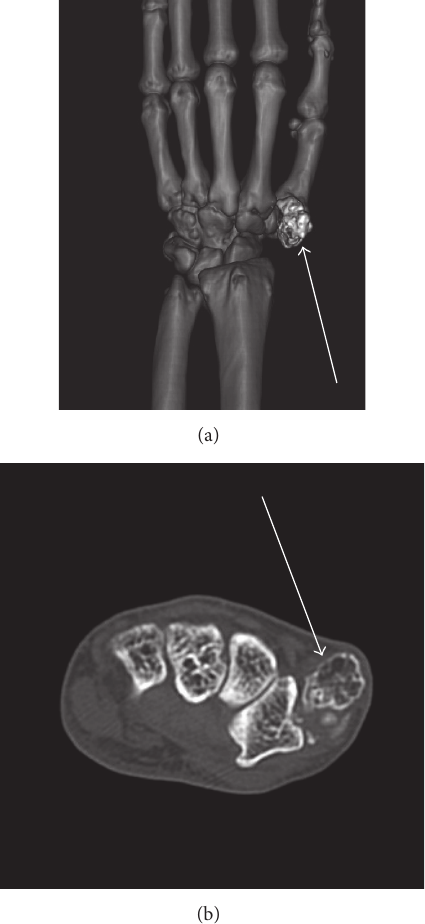
Figure 3: (a) Preoperative CT imaging of the left hand showing a nodule (white arrow) adjacent to trapezium and the base of the first metacarpal bone. (b) Axial section of CT imaging showing the tumor (white arrow).